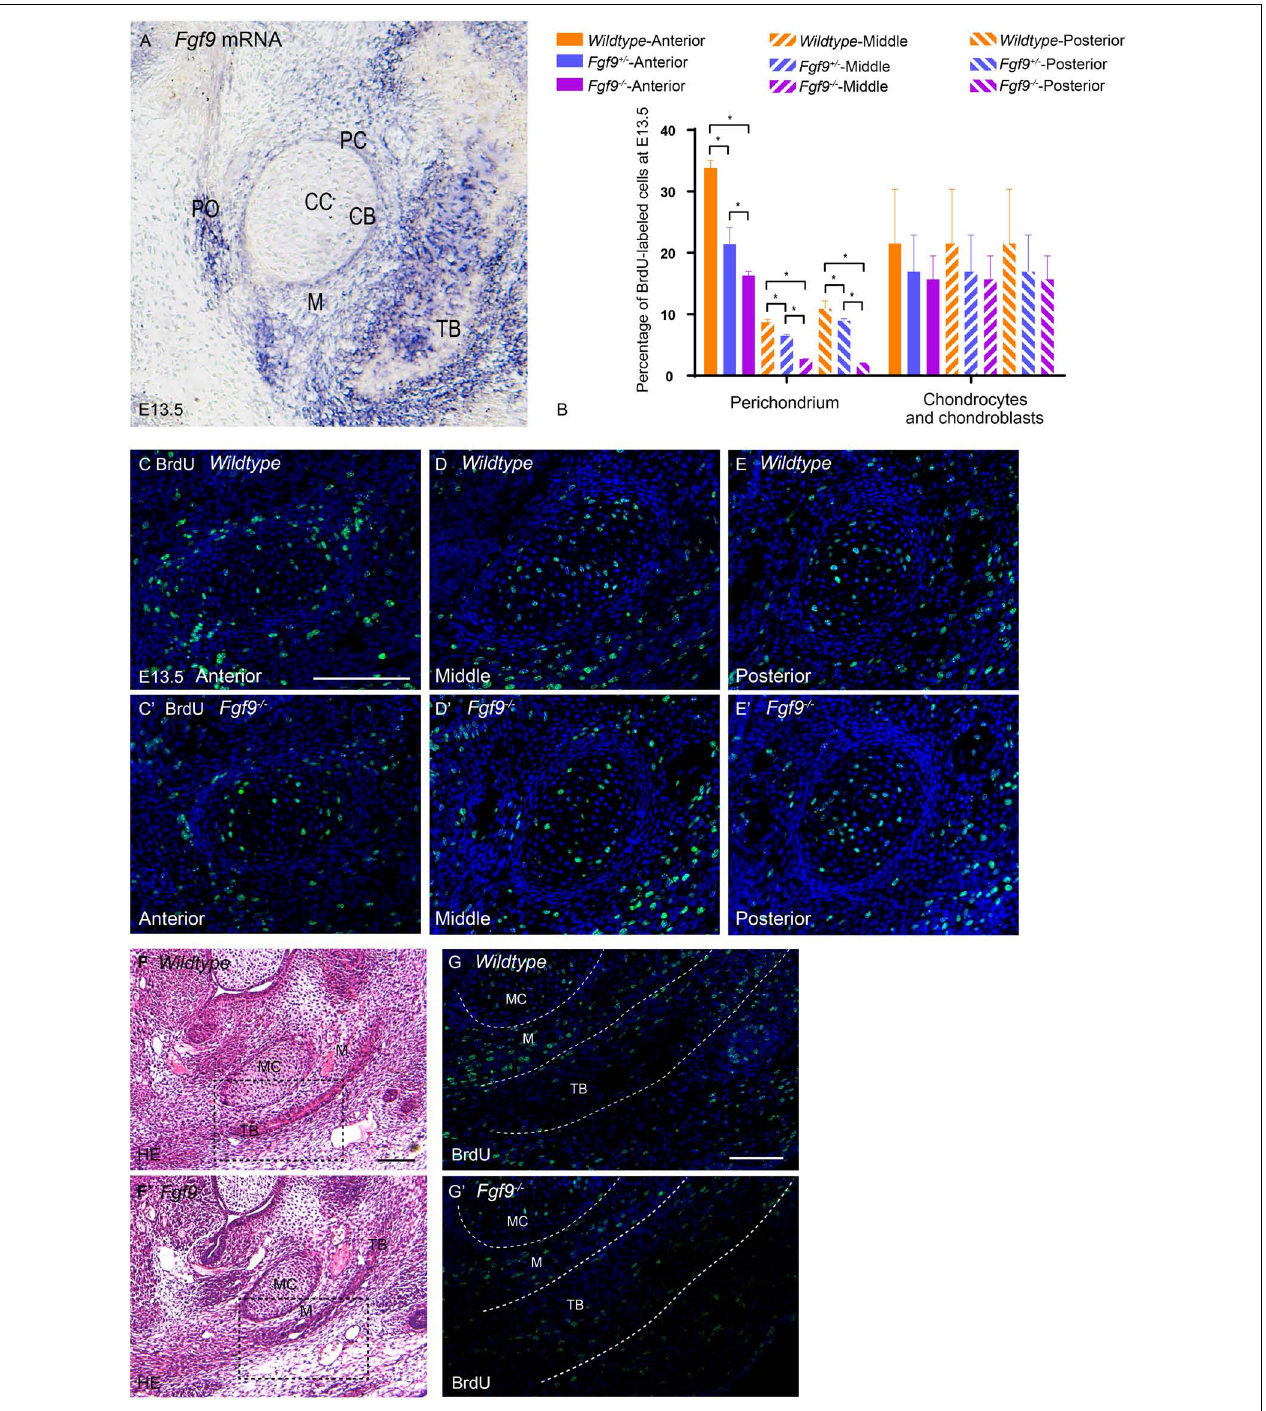
FIGURE 9 | Growth potential of Meckel’s cartilage is impaired in Fgf9 − / − embryos. (A) Fgf9 mRNA is located in the perichondrium, periosteum, trabecular bone, and mesenchyme surrounding bone and cartilage. (B) Quantification of BrdU-labeled cells in the perichondrium, chondrocytes, and chondroblasts in different sections of the palate. BrdU immunofluorescence of the anterior part of Meckel’s cartilage in (C) Wildtype and (C’) Fgf9 − / − mice. BrdU immunofluorescence of the anterior part of Meckel’s cartilage in (D) Wildtype and (D’) Fgf9 − / − mice. BrdU immunofluorescence of the anterior part of Meckel’s cartilage in (E) Wildtype and (E’) Fgf9 − / − mice. HE staining of the intramembranous ossification region of (F) Wildtype and (F’) Fgf9 − / − mice. The dotted-box regions in (F,F’) were examined with BrdU immunofluorescence, with magnified images in (G,G’) , respectively. * P < 0.05. PC, perichondrium. CC, chondrocyte. CB, chondroblast. TB, trabecular bone. PO, periosteum. M, mesenchyme. MC, Meckel’s cartilage. Scale bars = 100 µ m.